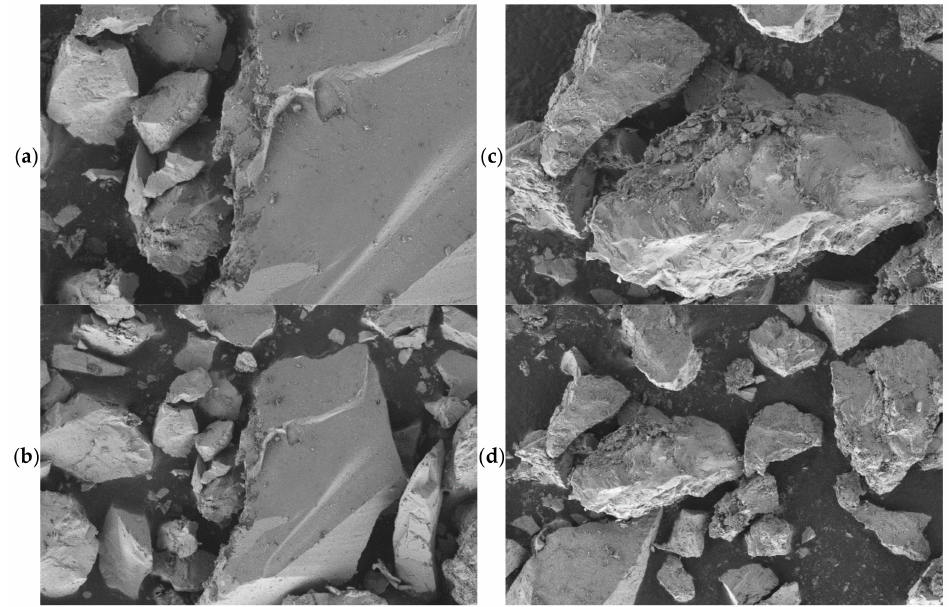
Figure 10. The surface morphology of azurite: ( a , b ) before CDDP treatment; ( c , d ) after CDDP treatment. Through the EDS analysis of the samples before and after the CDDP treatment, Fig- ure 11a shows that the electron energy spectrum only shows the peaks of Cu, C, and O elements, and the Cu content in the semi-quantitative analysis result is 56.3%, indicating that there are no other impurity elements in the surrounding area and the purity of azurite’s pure minerals is relatively high. Figure 11b shows that there are also S peaks in the electron energy spectrum. The atomic concentration of S is 1.32%, and some floccules also appear on the surface of the mineral, indicating that new substances have been formed. At the same time, the content of Cu is also reduced from 56.3 to 46.45%, meaning that CDDP may cover the Cu sites on part of the azurite surface [42].